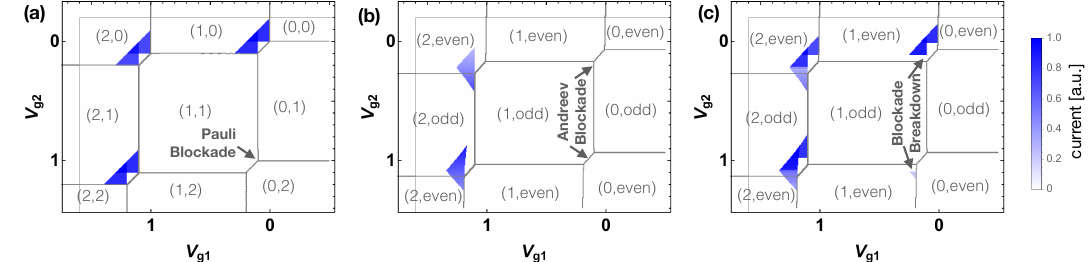
Figure 2: Zero temperature charge stability diagrams comparing Pauli and Andreev blockades. Current through the double quantum dot at fixed source-drain bias volt- age is plotted as a function of the gate voltages V dots. Gate voltages are in the units of dot charging energies U in brackets indicate the lowest energy states of the double dot. (a) Pauli blockade: double quantum dot with two normal metal leads at low source-drain bias. ∆ Γ = 0.01, where ∆ is the Andreev coupling in dot 2, Γ 2 2 neling rate between dot 2 and lead 2. (b) Andreev blockade: double quantum dot with one normal metal lead and one superconducting lead at low source-drain bias. ∆ = 0.25, Γ = 0. (c) Breakdown of Andreev blockade: when the source drain 2 2 bias exceeds the superconducting gap (which we reduce from infinite to 0.05 U this plot), the conductance triangles partially reappear. ∆ | ∆ E | > 0.05 else 0, where ∆ E is the energy difference between the initial and final states. Other parameters used: inter-dot charging energy U = − V = 0.1, tunneling rate between dot 1 and lead 1 Γ bias V 1 2 = 0.024, further details in the supplemental materials. dot 1 and dot 2 Γ 12